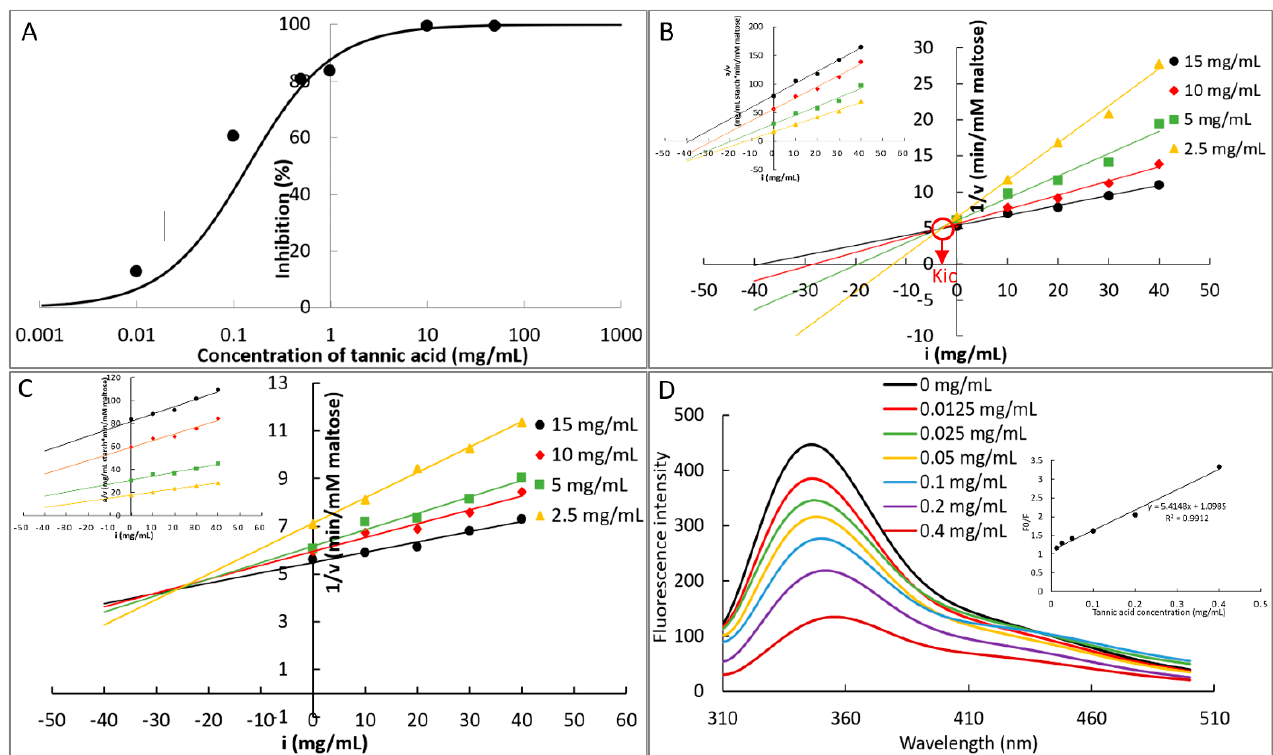
Figure 2. The mechanism in α -amylase inhibition of TA. α -Amylase inhibition at a series of TA concentrations determined by use of an EnzCheck TM ultra amylase assay kit, and the curve was fitted according to the IC 50 value calculation equation ( A ). Inhibition kinetics of TA for order 2 ( B ) and order 3 ( C ), in which Dixon and Cornish-Bowden (inserted) plots were described to obtain the competitive inhibition constant, K ic ; The quenching effect of TA on α -amylase fluorescence ( D ) and the fluorescence quenching constant K FQ was obtained from Stern-Volmer equation (inserted).